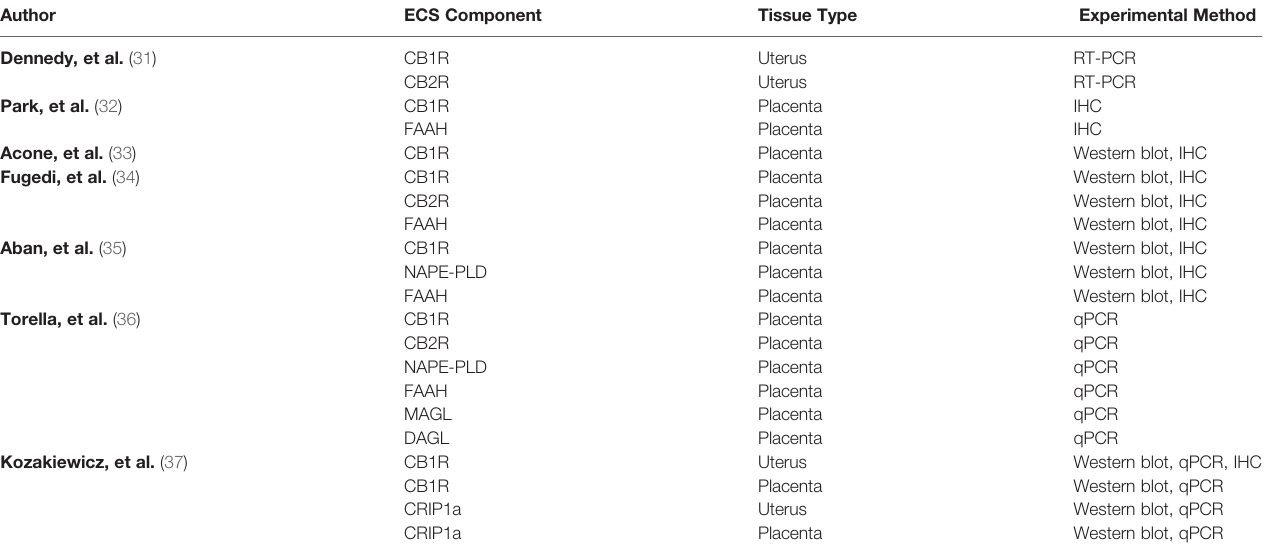
TABLE 1 | ECS components in human tissue mid- to